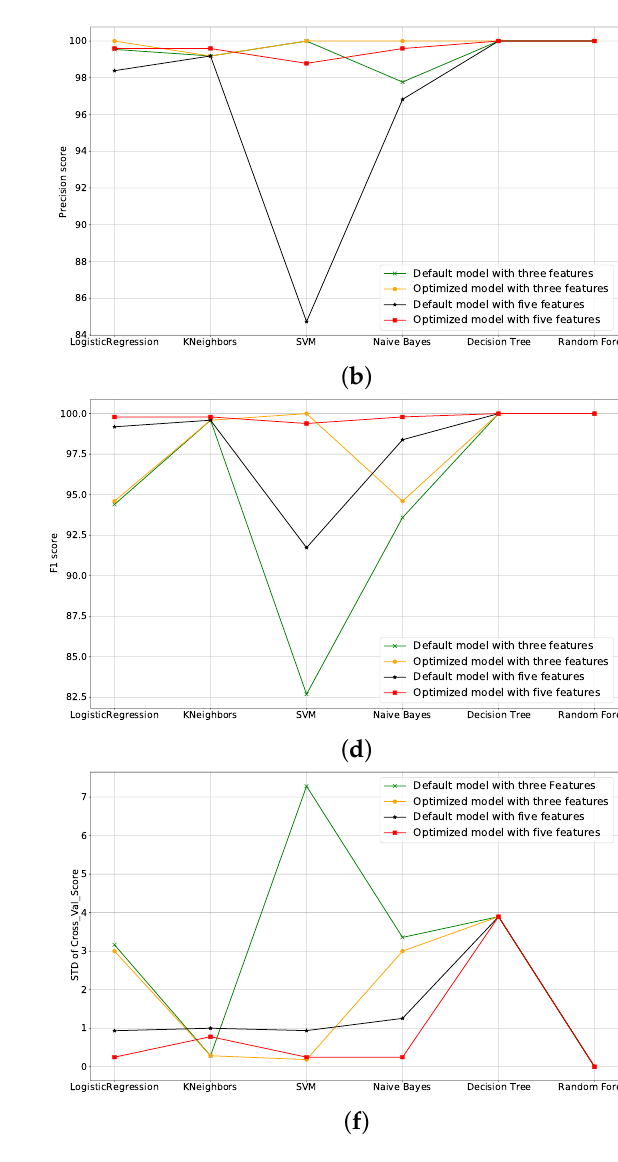
Figure 14. Comparison between selected ML models: ( a ) accuracy; ( b ) precision; ( c ) recall; ( d ) F1 score; ( e ) cross-validation score; ( f ) STD of cross-validation